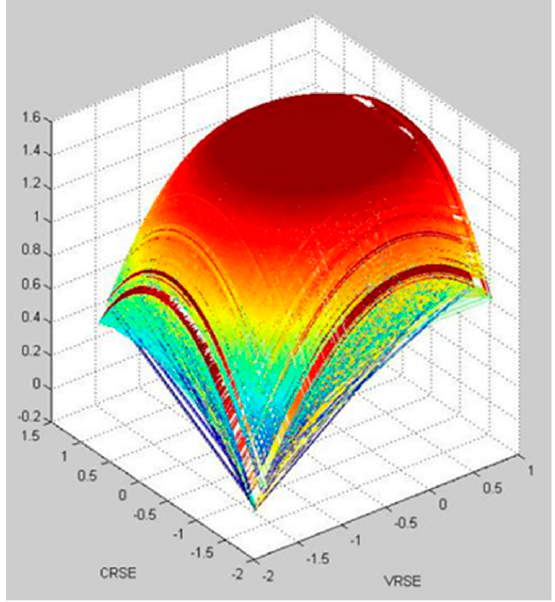
Figure 9. The visualization of simulation of the effect of Chinese outward FDI on wellbeing in Group 3.